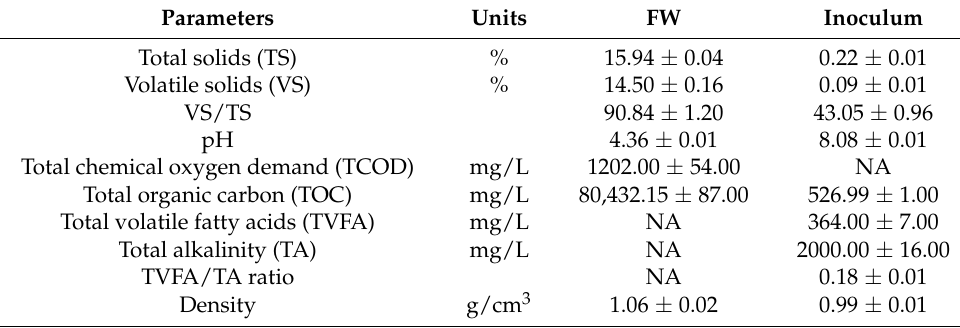
Table 1. Characteristics of the FW and inoculum used in the